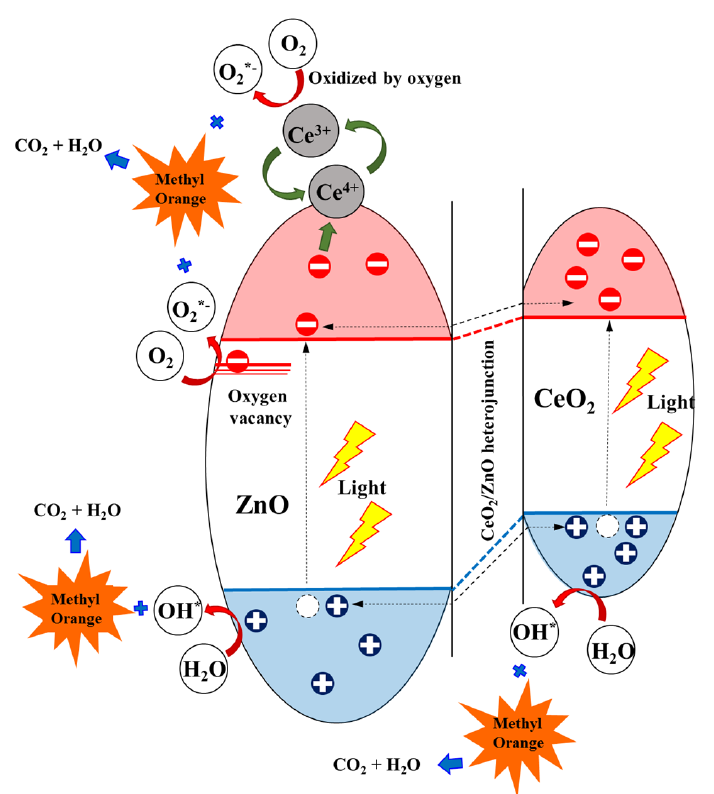
Figure 9. Electron trapping and charge transfer for methyl orange (MO) degradation using the Ce/ZnO